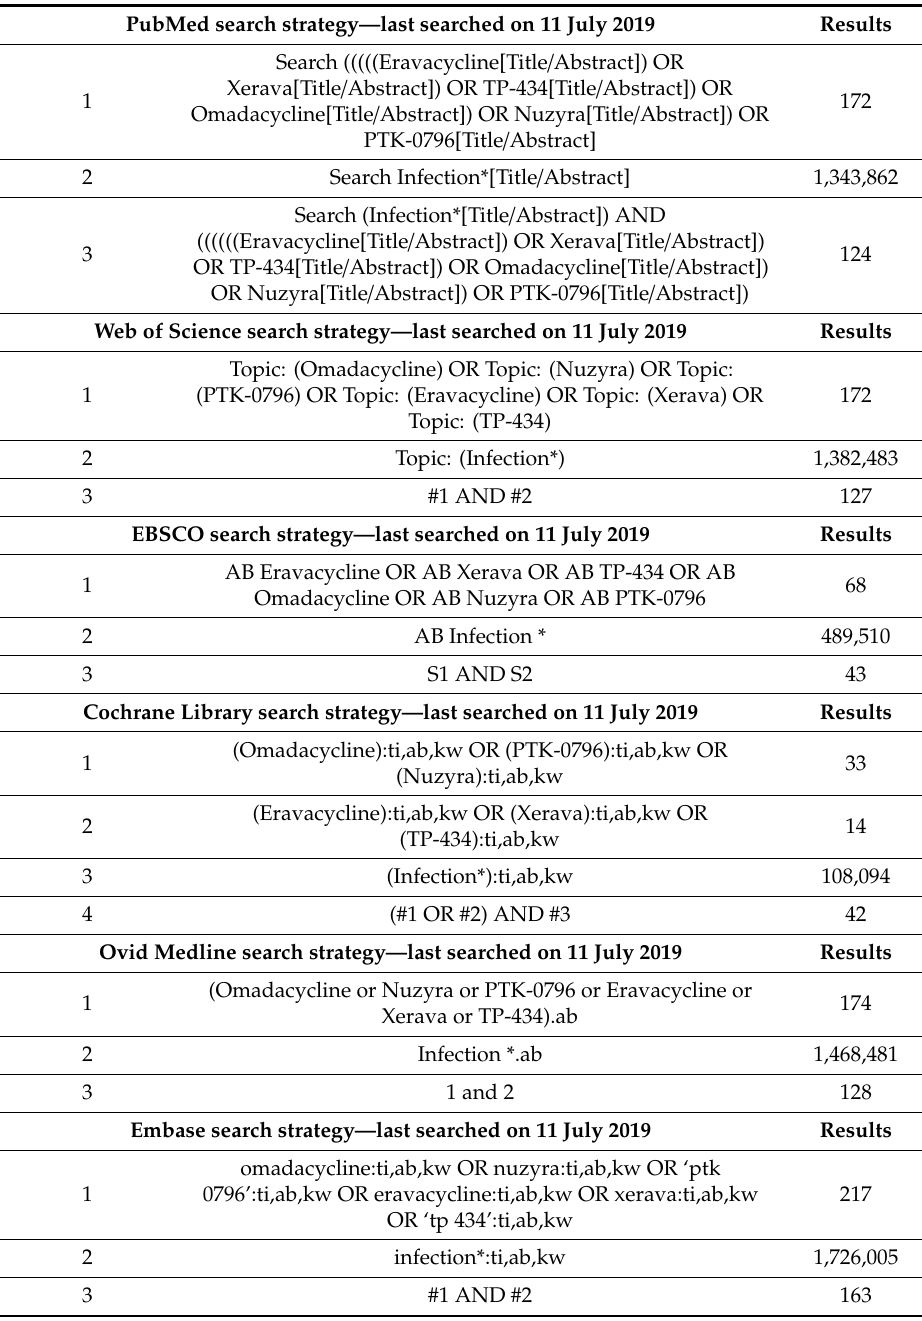
Table A1. Search